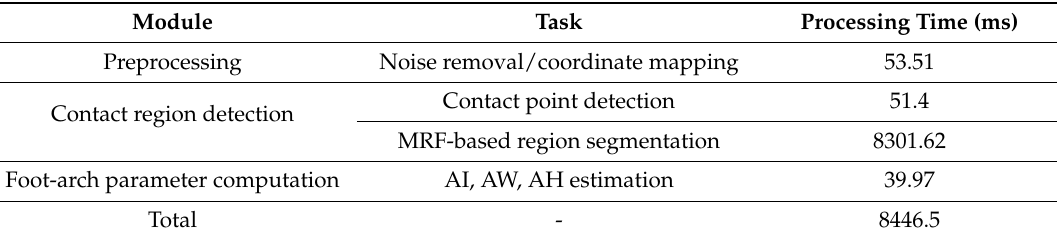
Table 6. Processing time of the analysis